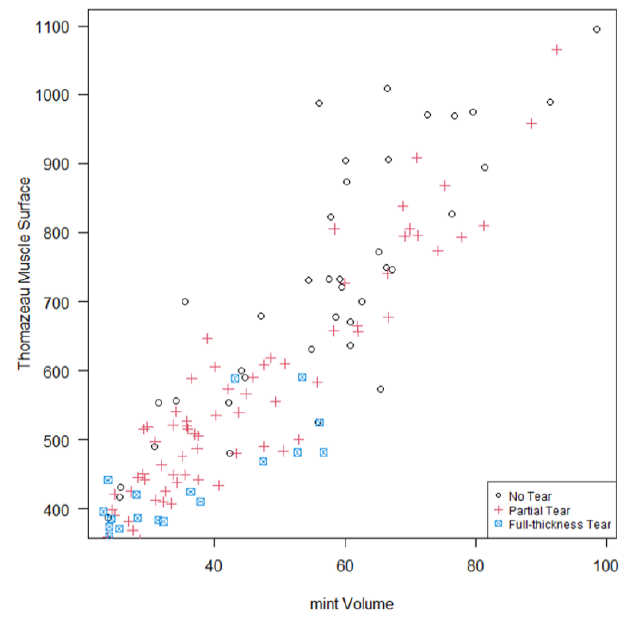
Figure 5. The correlation between OR values and muscle volumes was high for intact SSP tendons (0.84) and partial SSP tendon tears (0.93) but considerably reduced for full-thickness SSP tendon tears with medial retraction of the myotendinous unit (0.68).